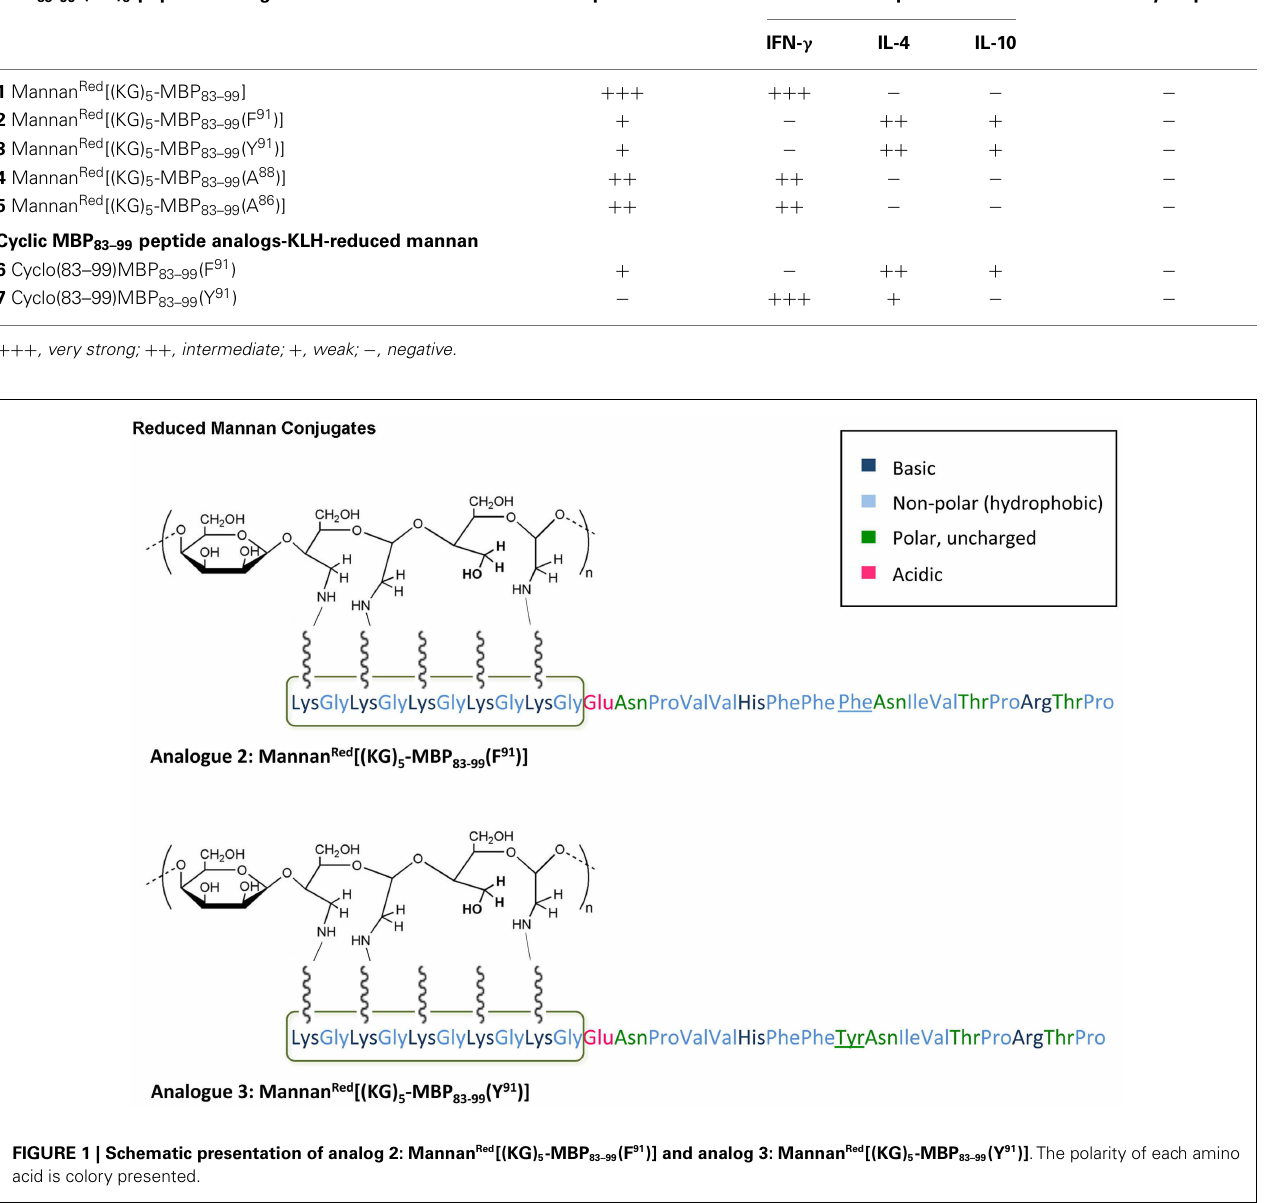
Frontiers in Immunology | Multiple Sclerosis and